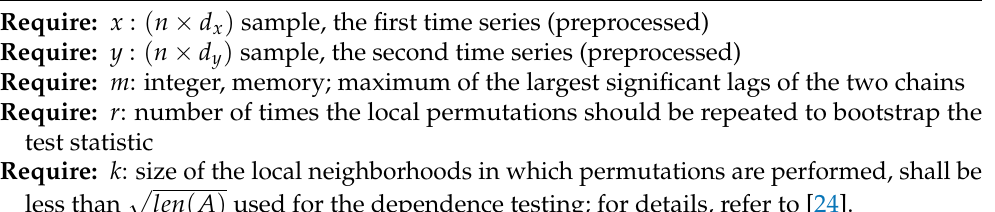
Algorithm 1 Procedure for finding the p -value of Markov property for the time series separately, and their joint time series, given lags 0, 1, and